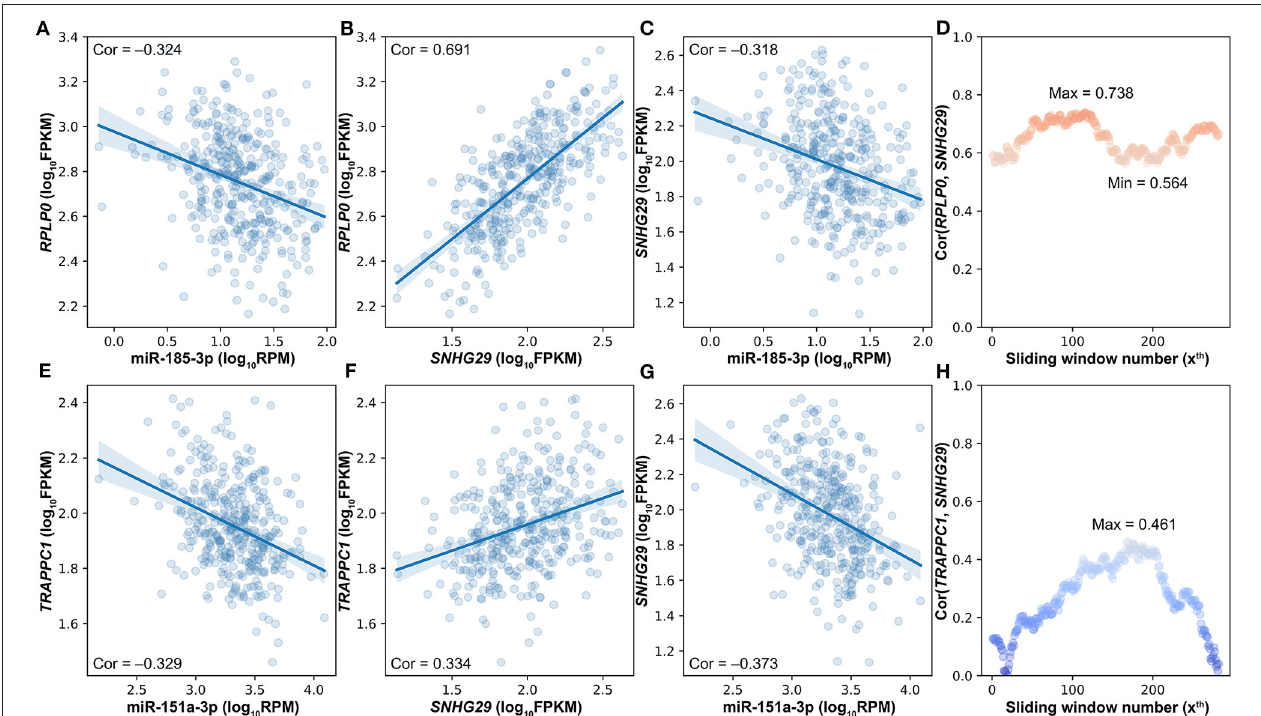
FIGURE 3 | The impact of miRNA on the interaction between ceRNA pairs in triplets. (A) The scatter plot of miR-185-3p and RPLP0 . (B) The scatter plot of SNHG29 and RPLP0 . (C) The scatter plot of miR-185-3p and SNHG29 . (D) The impact of miR-185-3p on the SNHG29–RPLP0 interaction. (E) The scatter plot of miR-151a-3p and TRAPPC1 . (F) The scatter plot of SNHG29 and TRAPPC1 . (G) The scatter plot of miR-151a-3p and SNHG29 . (H) The impact of miR-151a-3p on the SNHG29–TRAPPC1